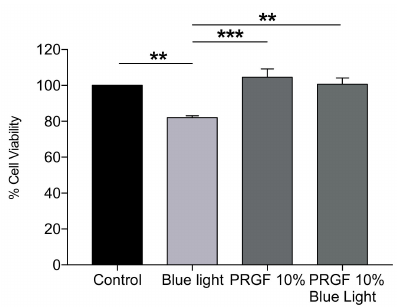
Figure 1. ARPE19 MTT assay ( n = 24) for viability. Plasma rich in growth factors (PRGF) 10% protects cells against blue light insult by increasing cell viability up to control levels. Statistical analysis: One-way Anova, Tukey multiple comparison test, ** p < 0.005, and *** p < 0.0005.